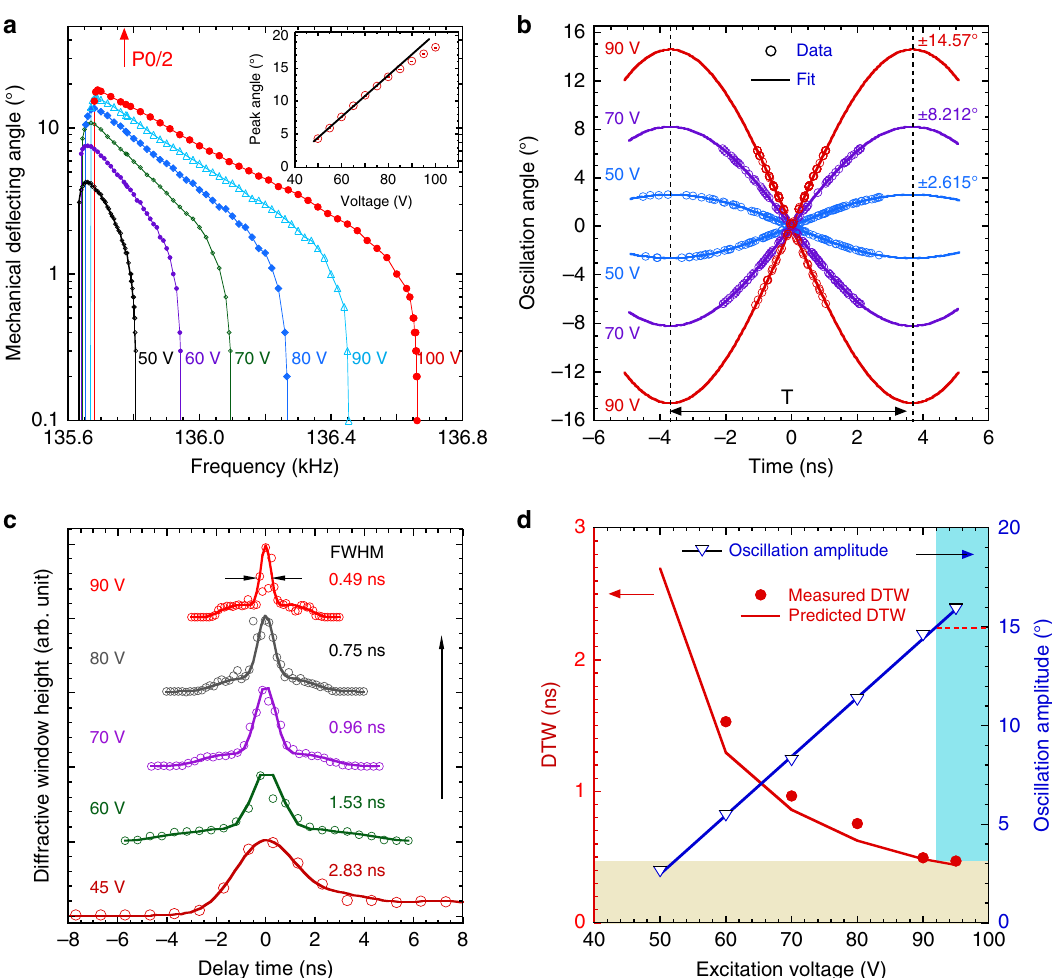
Fig. 3 Reaching sub-nanosecond diffractive time window by applying high excitation voltage. a Tuning curves of the P0/2 MEMS at excitation voltages from 50 to 100 V in the vicinity of P0/2, or half the Advanced Photon Source storage-ring frequency. Inset to a shows the peak amplitude as a function of the excitation voltage. b Precise measurement of oscillation amplitude using the X-ray pulses while the MEMS device is excited exactly at a frequency of P0/2. We note that the delay time covered only a fraction of the MEMS oscillation period near null delay time, where the oscillation amplitude measurement is extremely sensitive and more accurate than any optical and electrical methods available to date. T is the oscillation period equal to 2/P0, or 7.365 μ s. c DTW measured by 8-keV X-ray time-delay scans when the excitation voltages increased from 60 to 90 V, at which time the DTW width drops to below 0.5 ns. The curve denoted as 45 V is from an as-fabricated device in our previous work 29 that is not frequency-matched to X-ray pulses. The arrow pointing upward marks the direction of increasing oscillation amplitude. d Comparison between the expected and measured DTW as a function of the excitation voltage at 135.777 kHz. The expected DTW is calculated using Eq. 1 and the amplitude values from b , which have a linear relationship with the excitation voltage, shown as the blue symbols (data) and line (linear fi t). The shaded areas indicate sub-nanosecond DTW where it becomes impractical to use a higher voltage to achieve narrower DTW in P0/2 MEMS